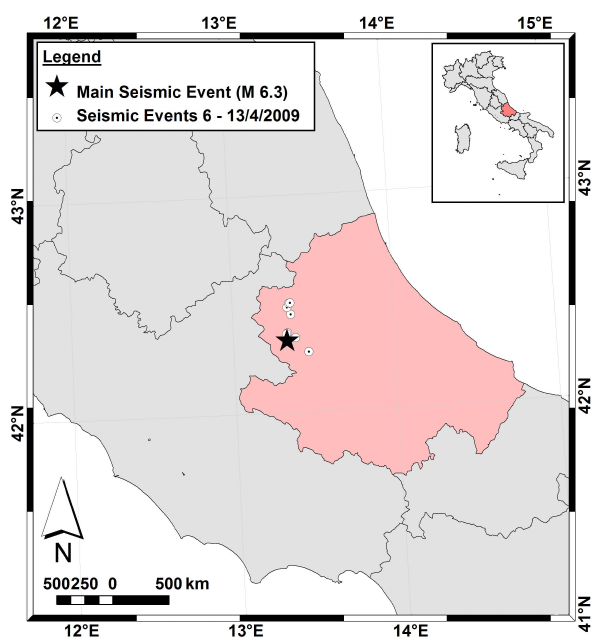
Fig. 4. Map of Abruzzo (Italy) and surrounding regions showing the locations of the epicentres of the earthquakes ( M ≥ 4.0) from 6 April to 13 April 2009. The black star indicates the main event ( M = 6.3) of 6 April